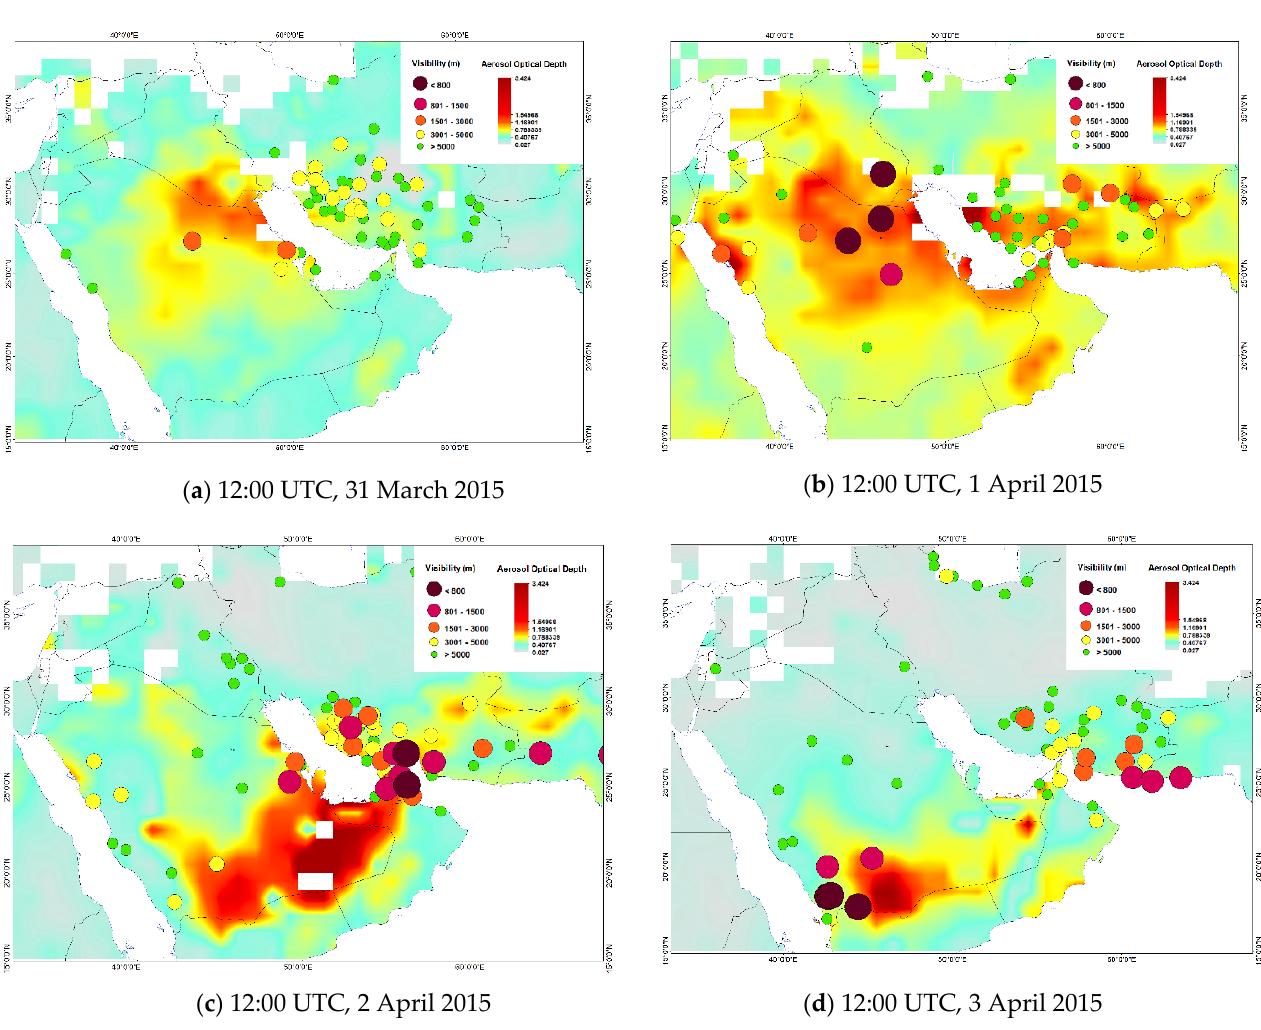
Figure 1. Deep Blue Aerosol Optical Depth Land Images superimposed with visibility reduction recorded by synoptic stations in five categories (less than 800 m, 801–1500 m, 1501–3000 m, 3001–5000 m and more than 5000 m) between 31 March and 3 April 2015 (12:00 UTC) ( a – d ).